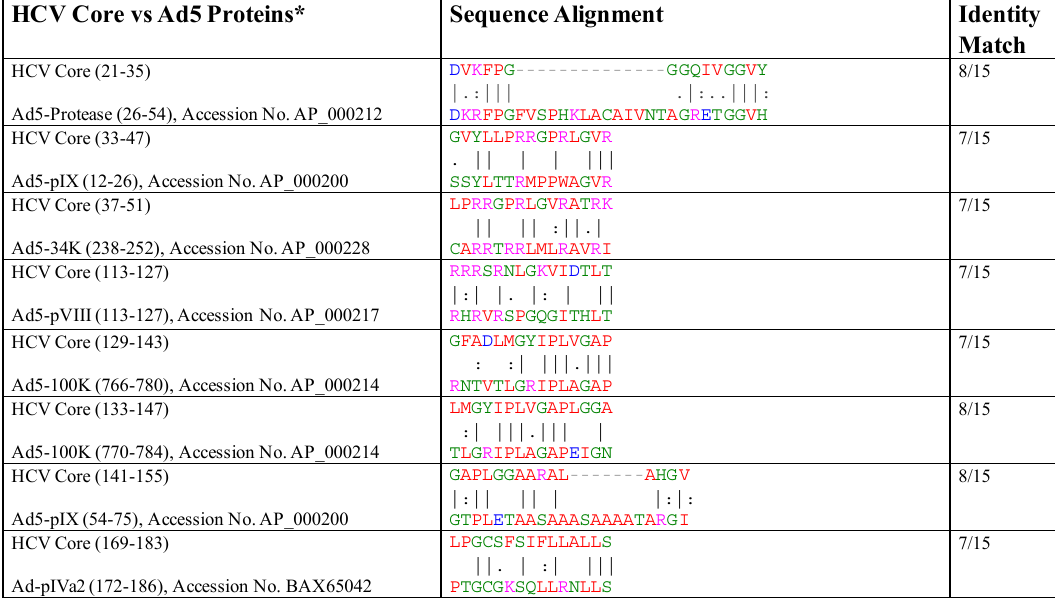
* Protein sequence identifier for Ad5 proteins are shown in the table. A | (vertical line) indicates positions with fully conserved residue. A : (colon) indicates conservation between groups of strongly similar properties. A . (period) indicates conservation between groups of weakly similar